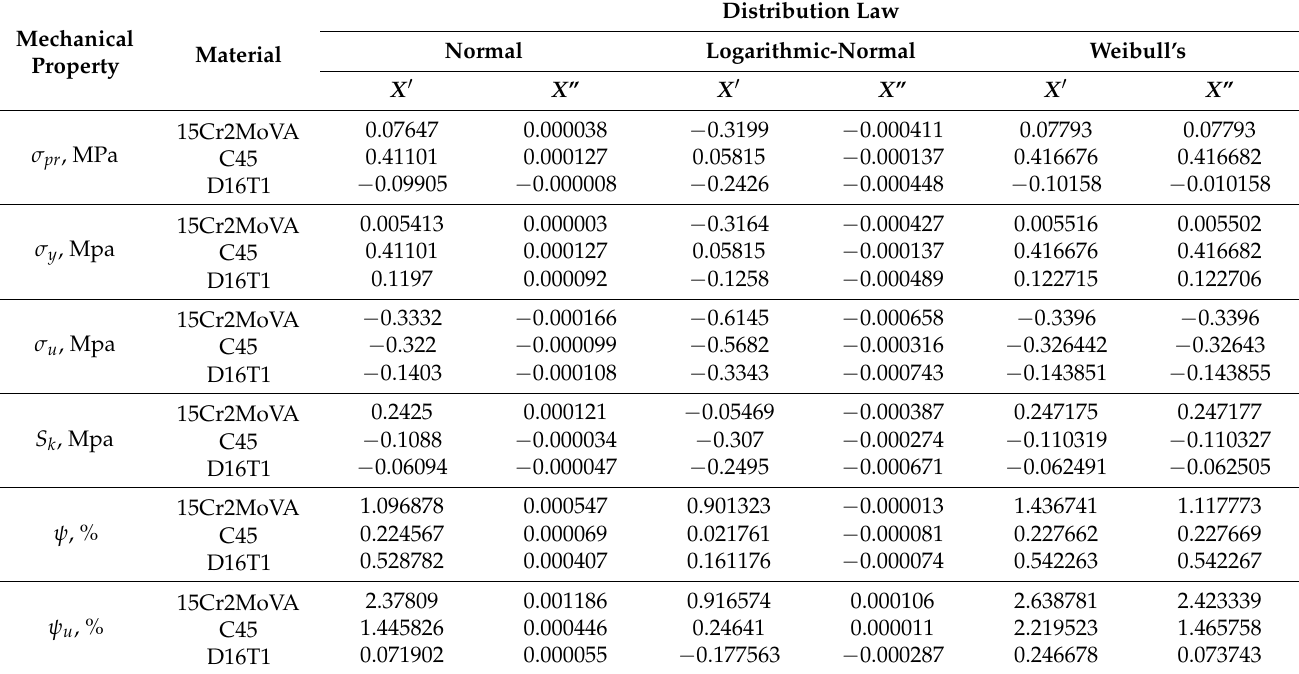
Table 5. Coefficients of skewness for mechanical properties under the statistical distribution